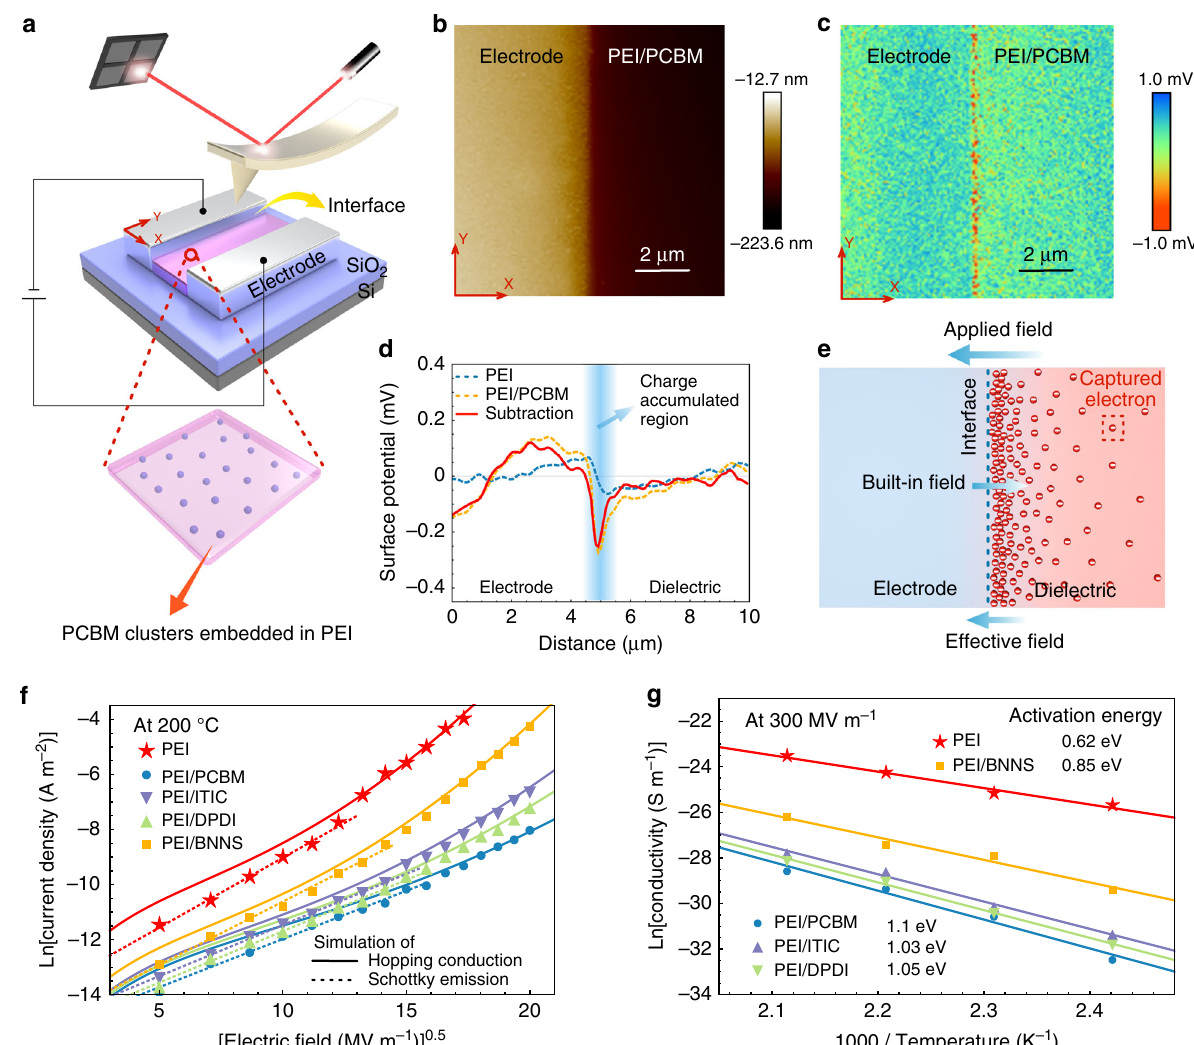
Fig. 2 Mechanism to the suppression of electrical conduction. a Schematic diagram of the KPFM testing. The circuit is used for charge injection prior to the measurement, and is disconnected during the measurement. b Topography of the PEI/PCBM composite. c Surface potential mapping of the PEI/PCBM composite. d Surface potential pro fi les along the horizontal axis derived from the surface potential mappings ( c and Supplementary Fig. 14b). The amplitude of surface potential is averaged along the y direction in the surface potential mappings. The subtraction (red curve) of surface potential between the pristine PEI and the PEI/PCBM composite excludes the in fl uence of the different energy levels between the electrode and the polymer. e Schematic illustration of the built-in electric fi eld formed by the molecular semiconductor captured electrons. f Current density as a function of applied electric fi eld of the pristine PEI, the all-organic composites and the PEI/BNNS nanocomposite measured at 200 °C. g Arrhenius function of conductivity for the pristine PEI, the all-organic composites and the PEI/BNNS nanocomposite measured at the applied electric fi eld of 300 MVm − 1